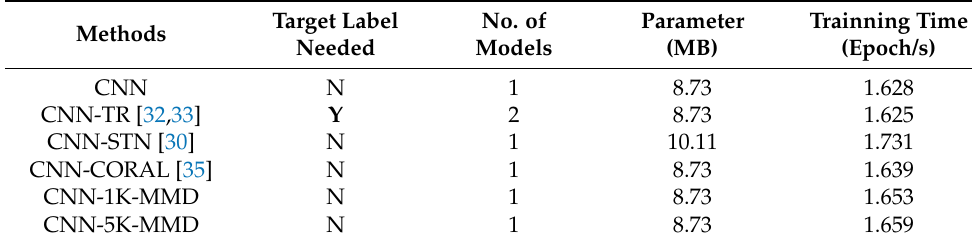
Table 4. State-of-the-art AMC method in comparison.